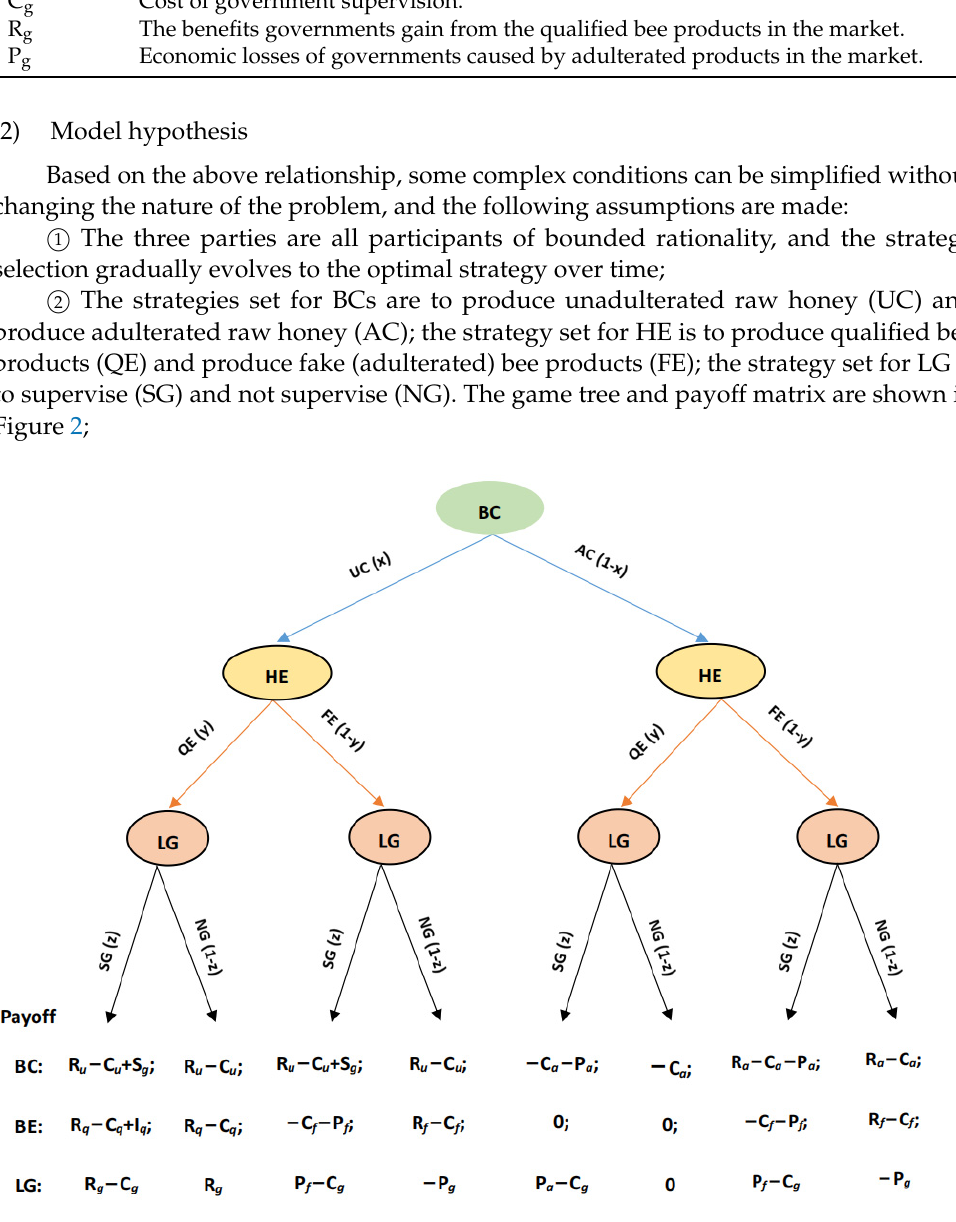
Figure 2. Game tree and payoff matrix of BCs, HEs, and LGs.